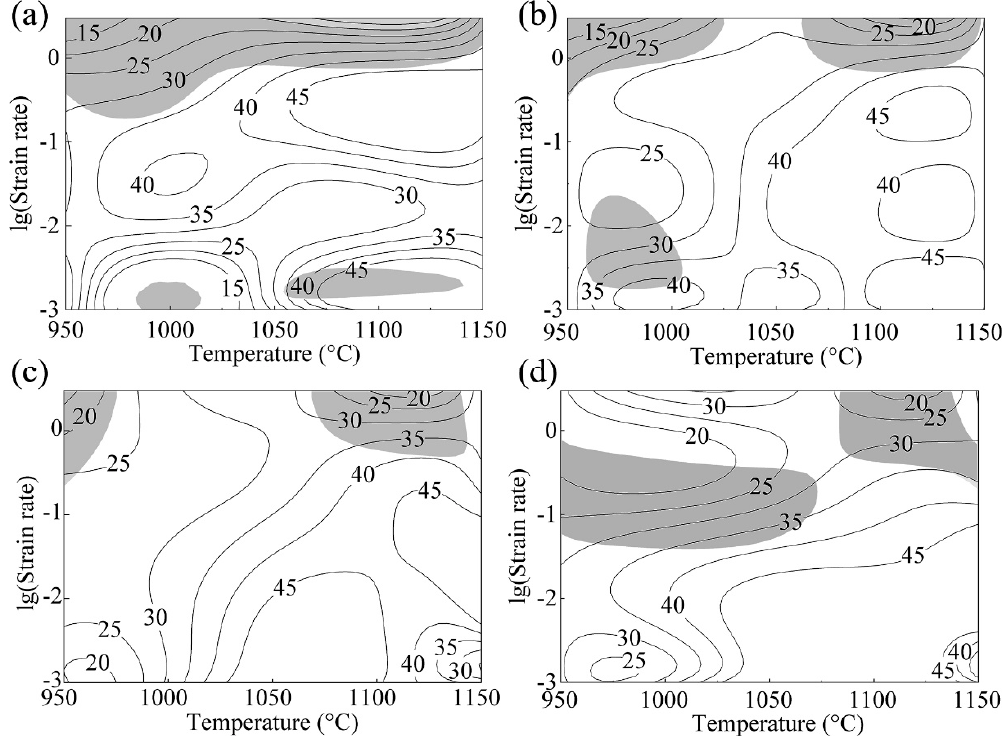
Figure 7. Processing maps of GH4698 at the strains of ( a ) 0.2, ( b ) 0.4, ( c ) 0.6, and ( d ) 0.8.